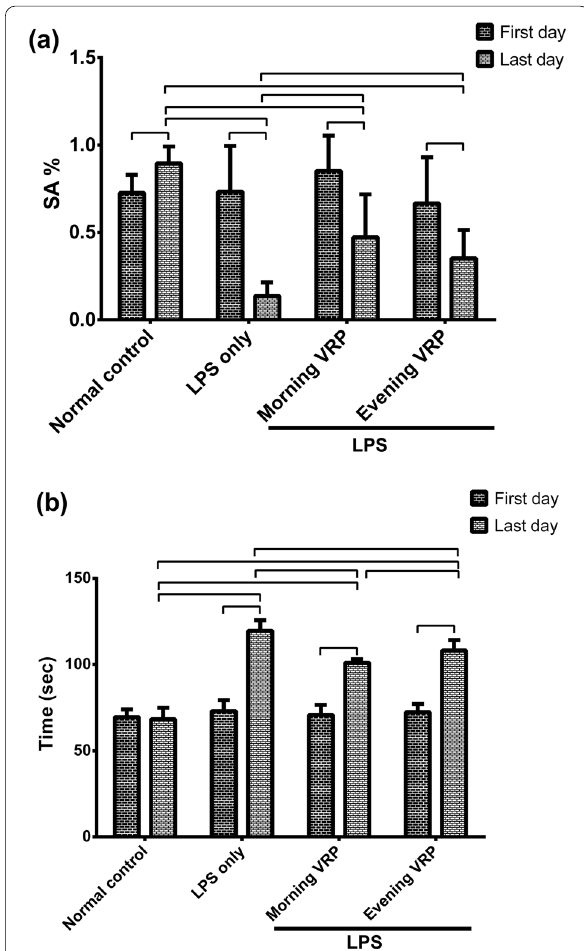
Fig. 1 Effect of VRP on behavioral tests of the experimental mice. a Y-maze test and b Pole climbing test. Data are expressed as the mean SD and were analyzed using one-way ANOVA followed by ± Tukey post hoc test. Values were considered significantly different at P < 0.05. LPS: lipopolysaccharides, VRP: verapamil, SA%: percent of spontaneous